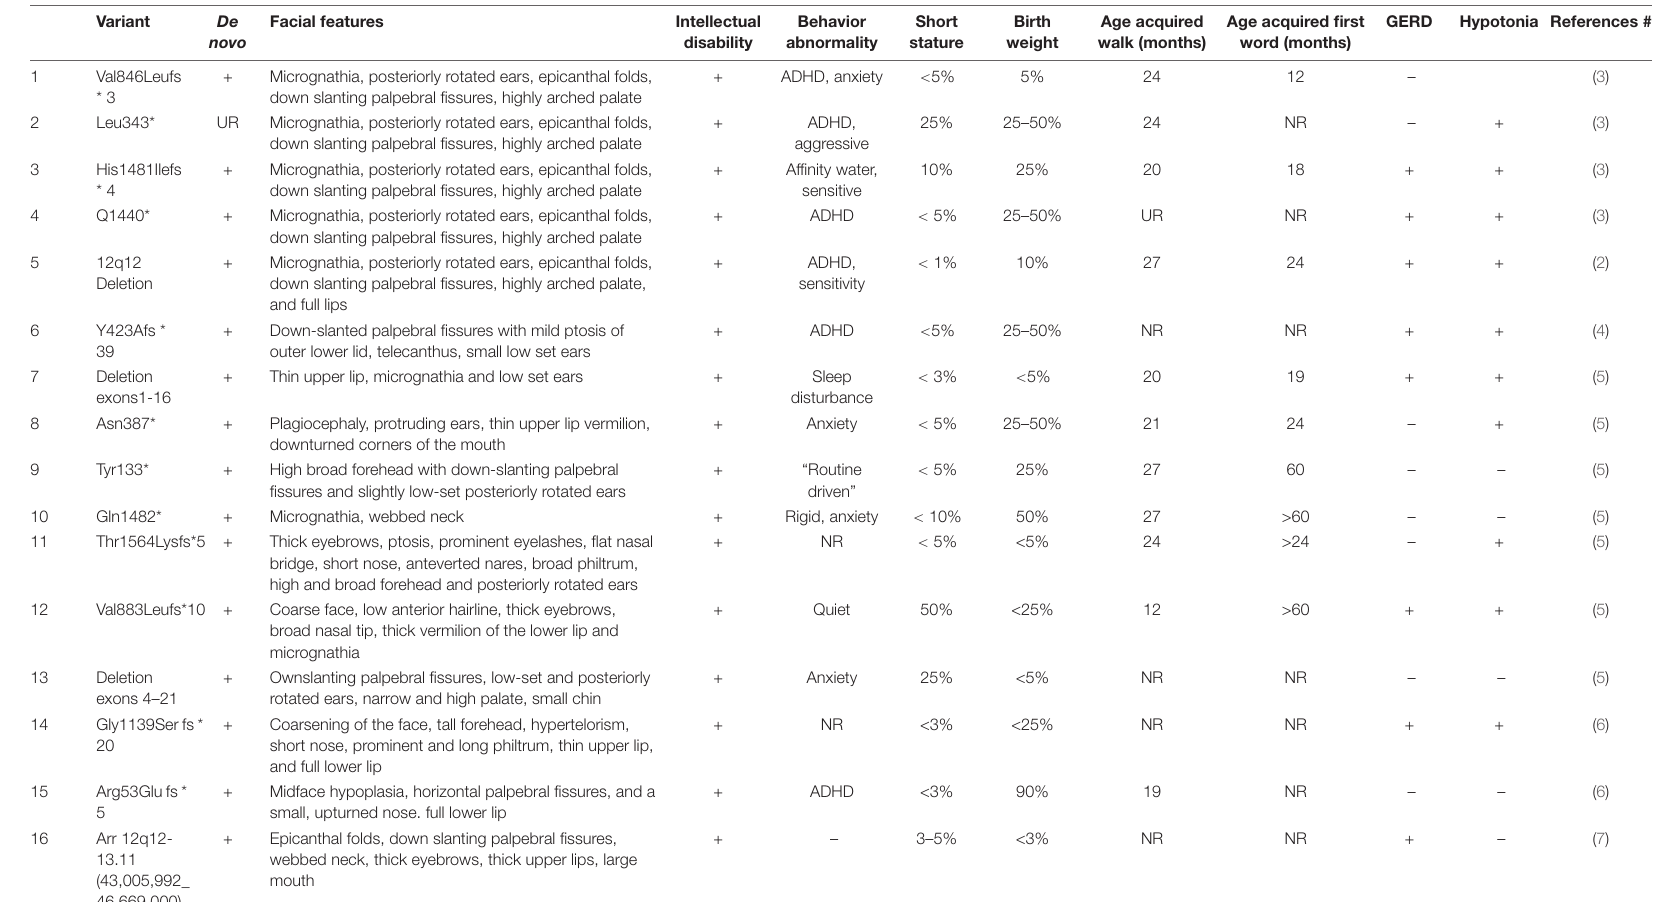
TABLE 1 | Summary of the features of Coffin-Siris syndrome with ARID2 mutation reported in the